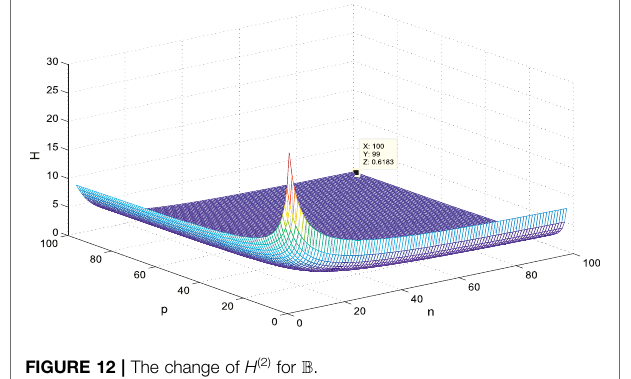
FIGURE 12 | The change of H (2) for B .